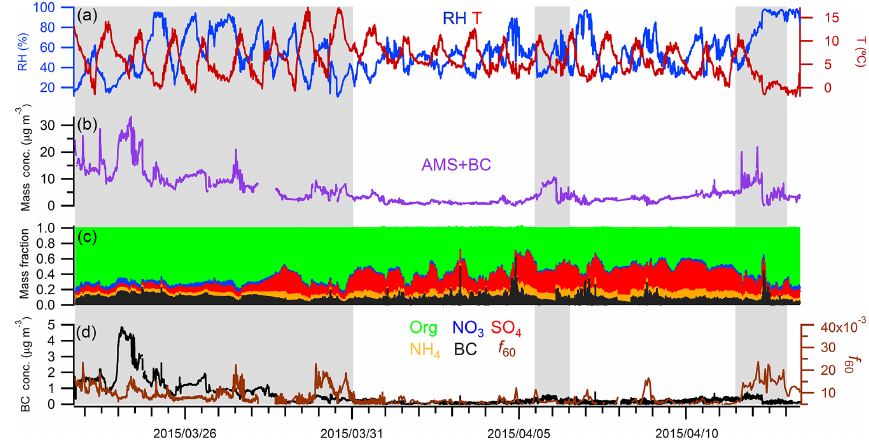
Figure 2. A time series of (a) relative humidity and temperature, (b) total mass concentrations from AMS plus the black carbon (c) mass fractions of different chemical species and (d) concentrations of black carbon and f 60 . The gray background denotes the three biomass burning events (identified in Sect. 4.1).